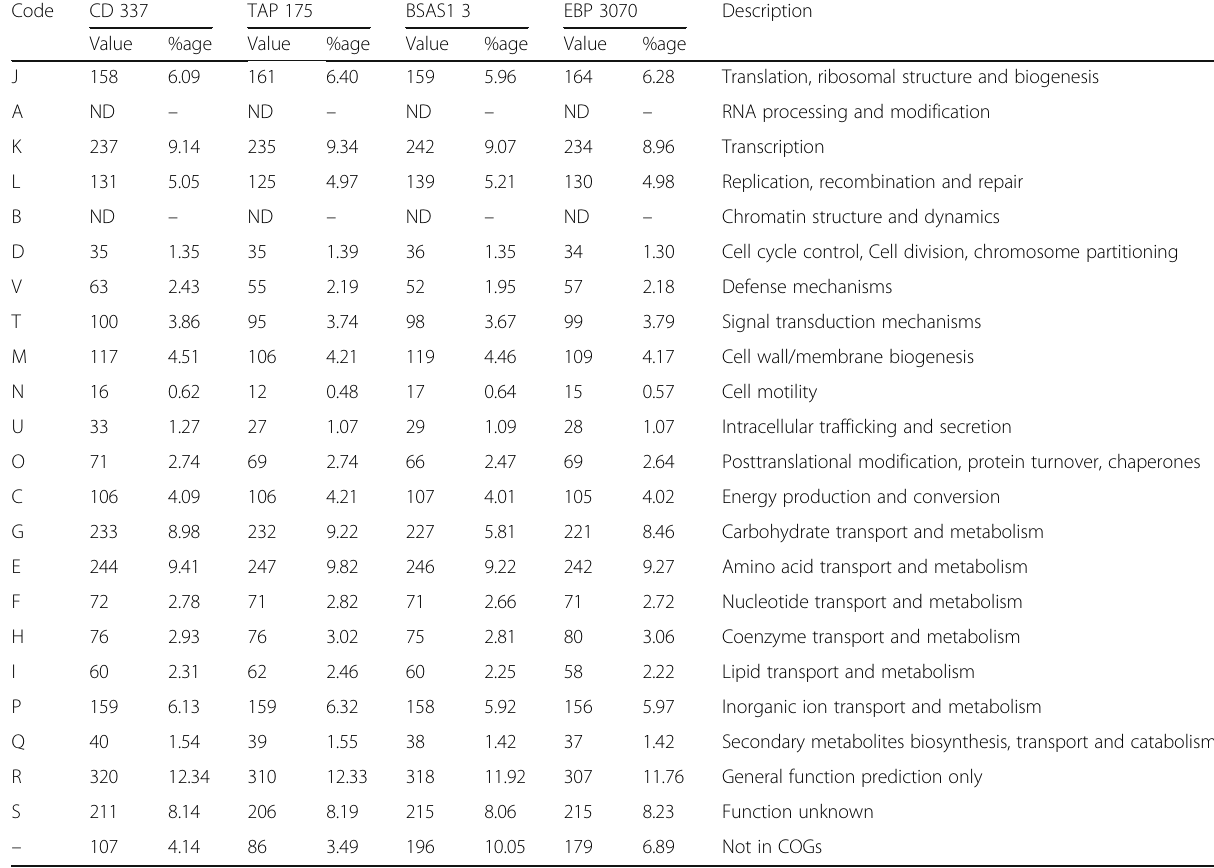
Table 4 Number of genes associated with general COG functional categories Code